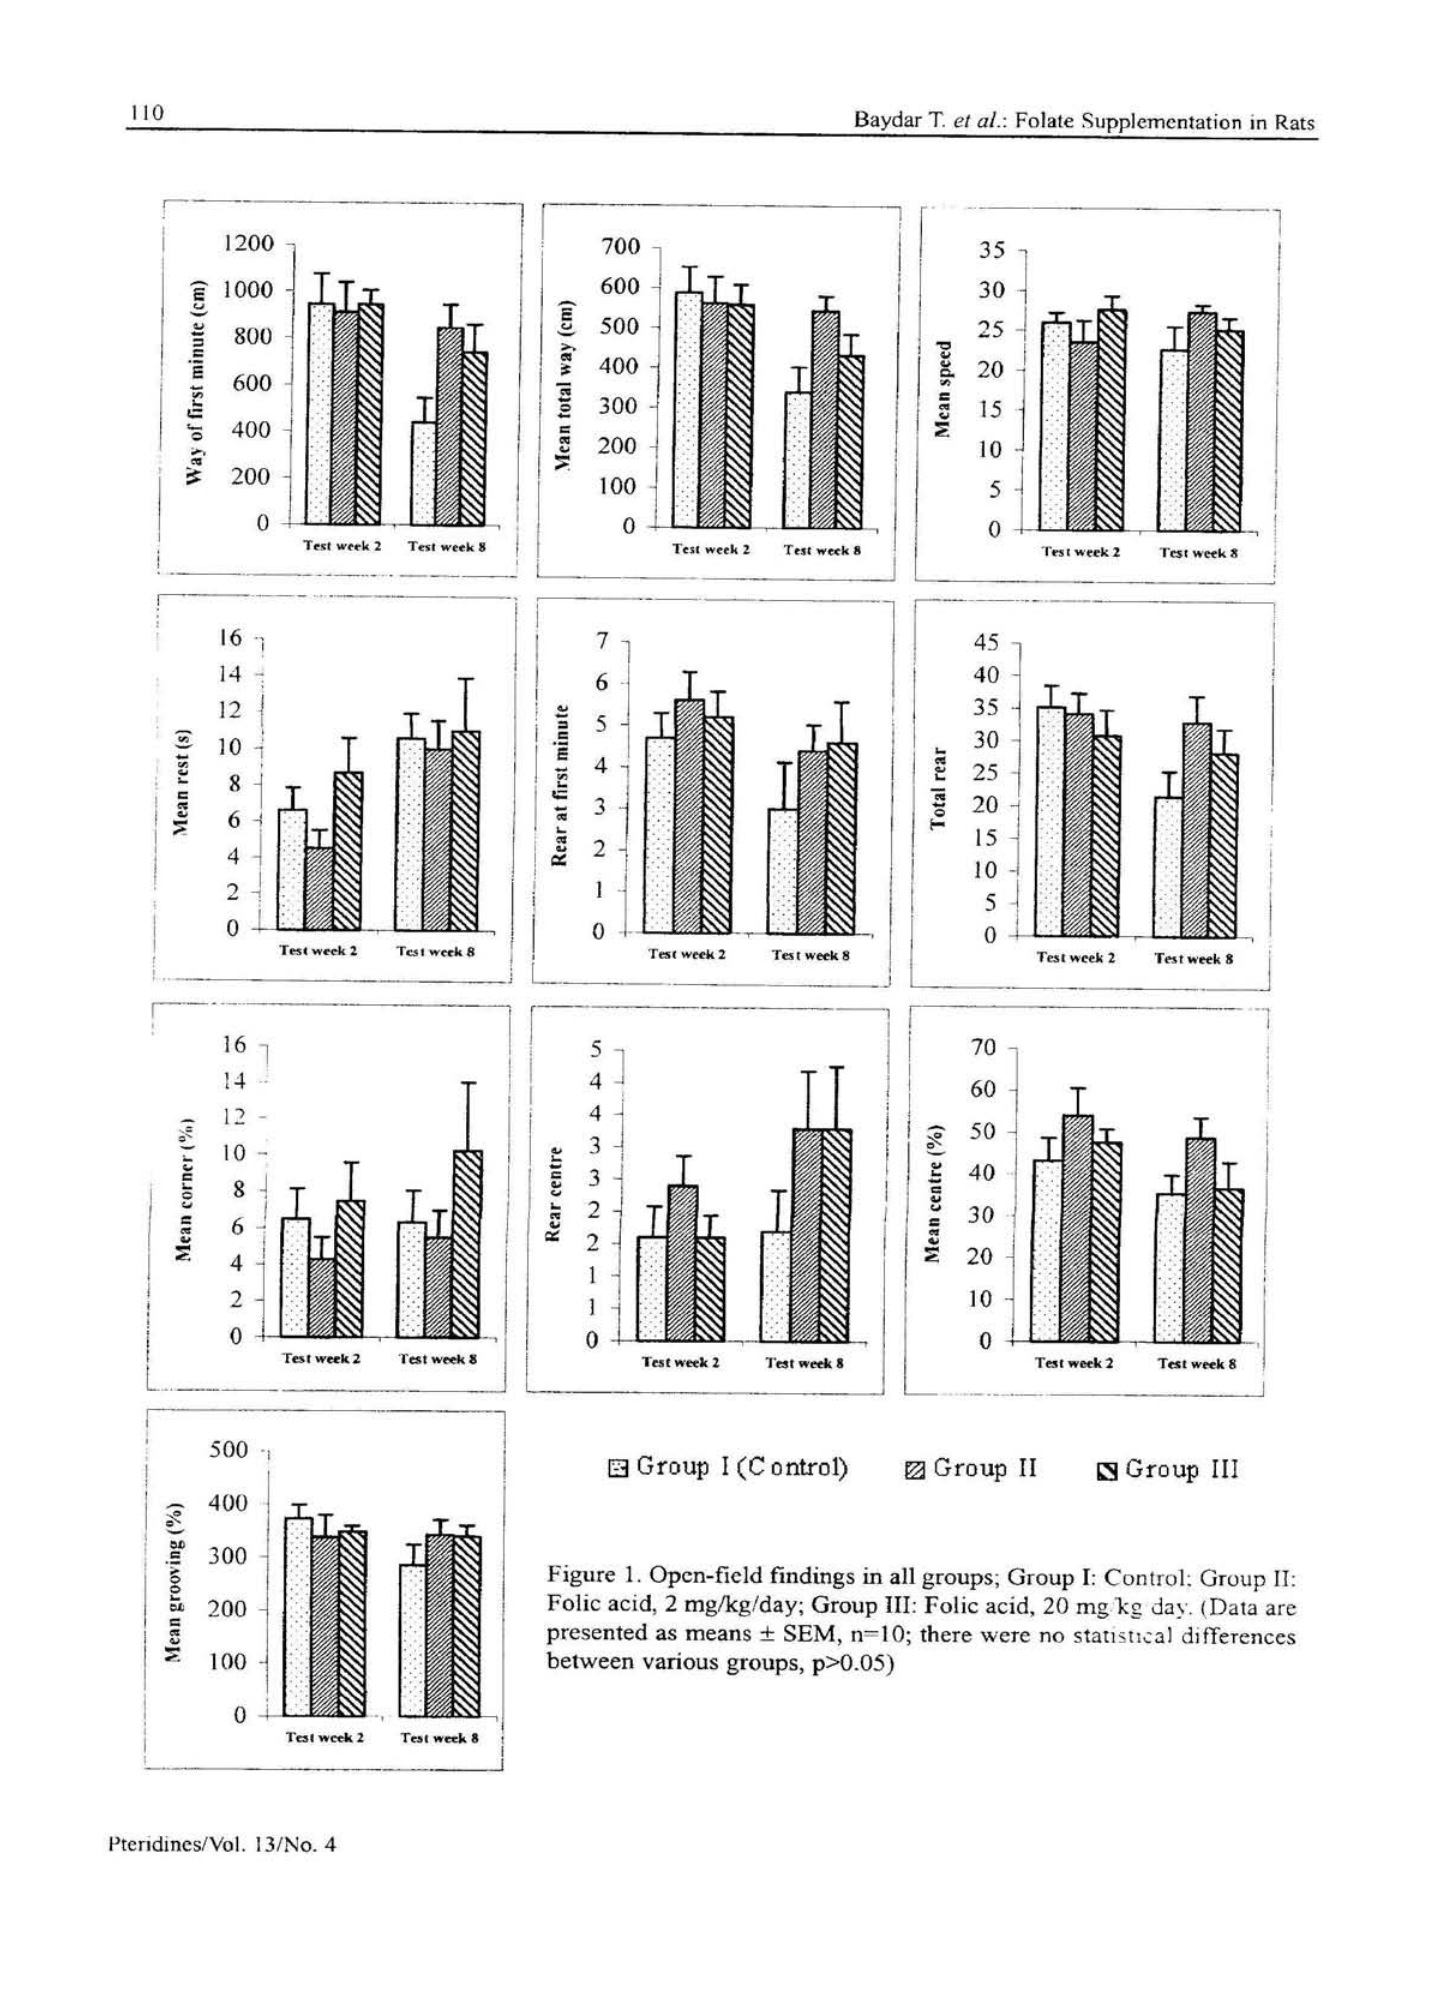
Figure 1. Open-field findings in all groups; Group I: Control: Group II: Folic acid, 2 mg/kg/day; Group III: Folic acid, 20 mg /kg day. (Data are presented as means ± SEM, n=10; there were no statistical differences between various groups,